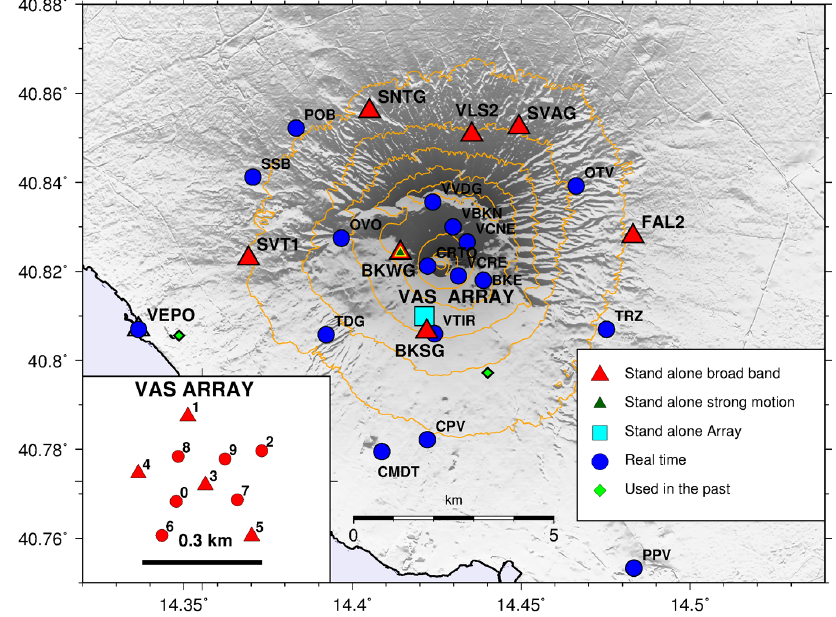
Figure 2. Topography map of Mt. Vesuvius with the local seismic network currently installed (August 2015). The left bottom inset shows the current configuration of VAS